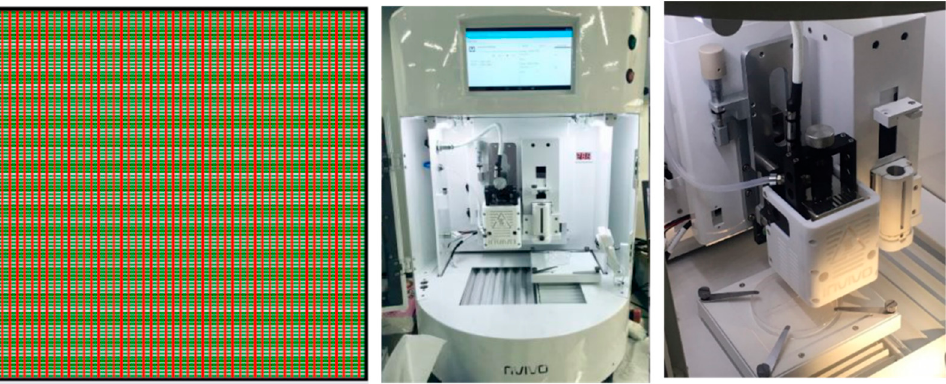
Figure 1. Grid scaffold pattern (top view) designed and produced for 3D-printing technique using the Rokit Invivo Multi-Use Hybrid Bio 3D Printer.